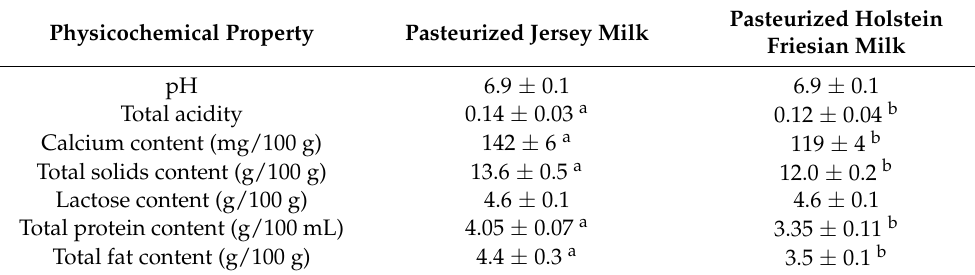
Table 1. Physicochemical properties of pasteurized Jersey or Holstein Friesian milk